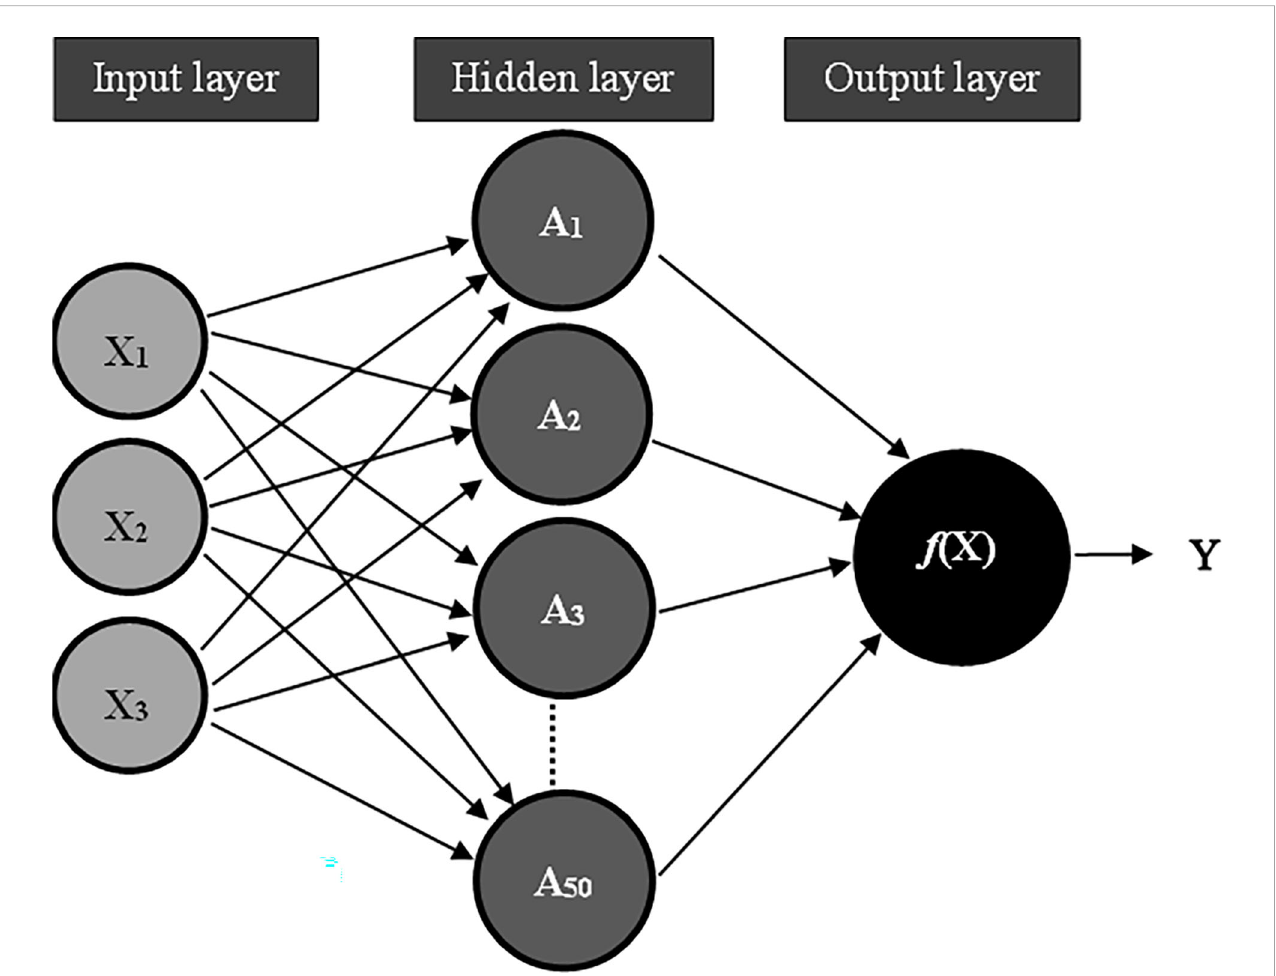
FIGURE 1 The architecture of a single layer neural network used in this study with illustration adopted with modi fi cation from James et al. (2021). X 1 , X 2 , and X 3 represent rainfall from September to December, rainfall from January to April, and rainfall from May to July respectively. A 1 , A 2 , … , A 50 represent activations A k for the nonlinear transformations of linear combinations of inputs. The function f(X) was solved using activations A k from the hidden layer as inputs to predict an observation,